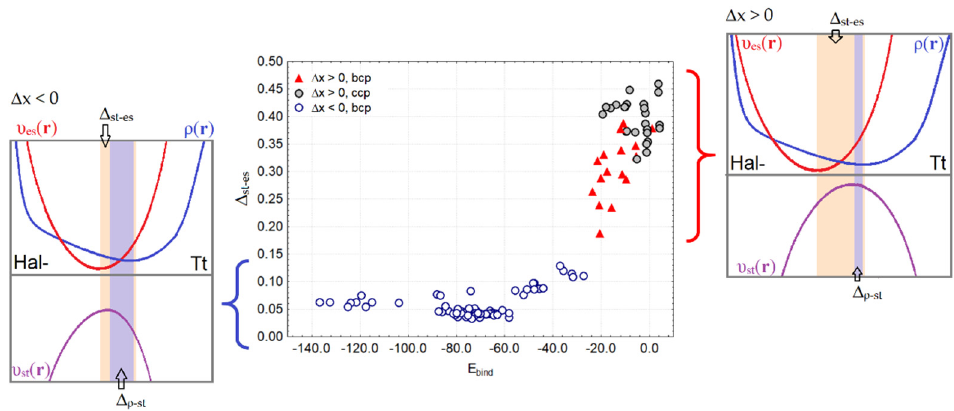
Figure 5. The gap width between positions of electrostatic potential minimum and static potential maximum, (Å) along interatomic line Hal − …Tt related with the binding energy in Y–TtX 3 …Hal − complexes.